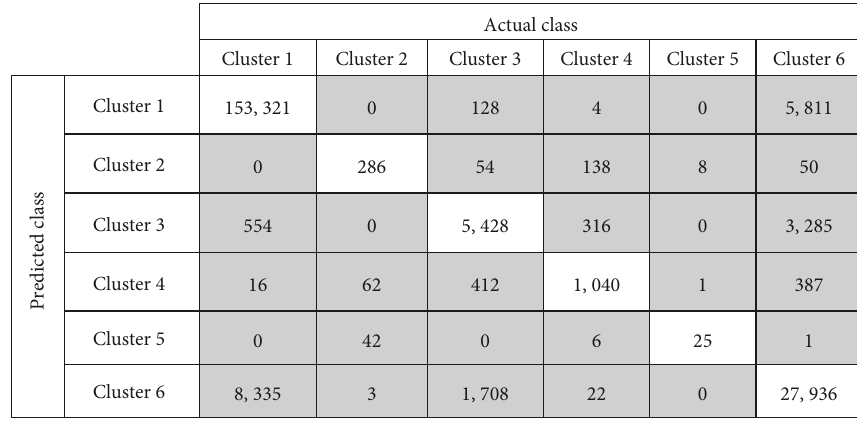
Figure 4: Confusion matrix table of ANN model. Table 14: Confusion matrix of ANN model.